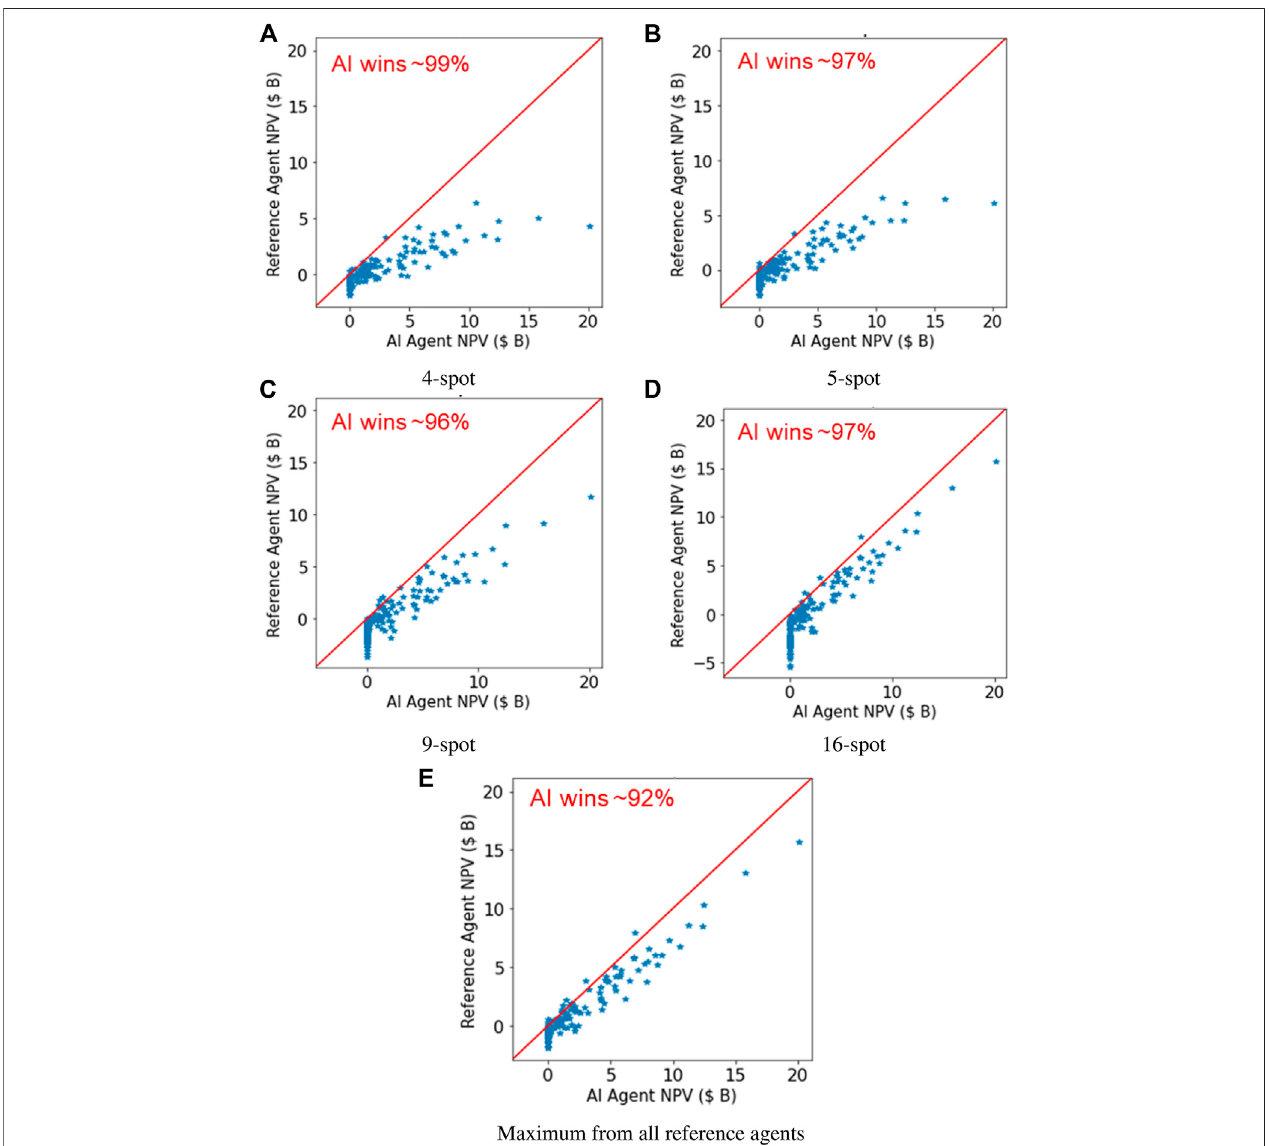
FIGURE8| Comparisonofthebestarti fi cialintelligence(AI)agenttrainedusingthedual-action probabilityrepresentation withthereferencewell-patternagentsfor the 2D case.